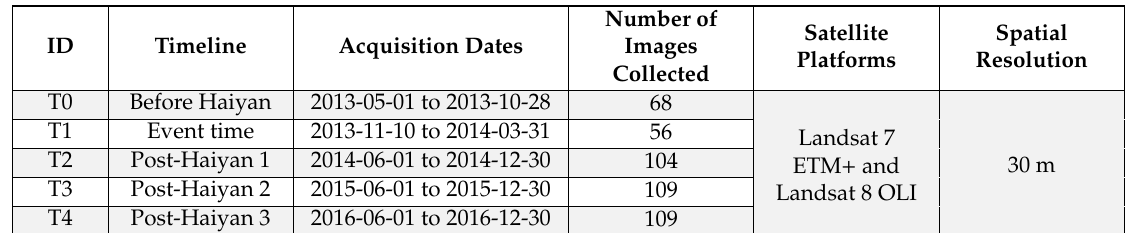
Table 1. Satellite images used in this study.